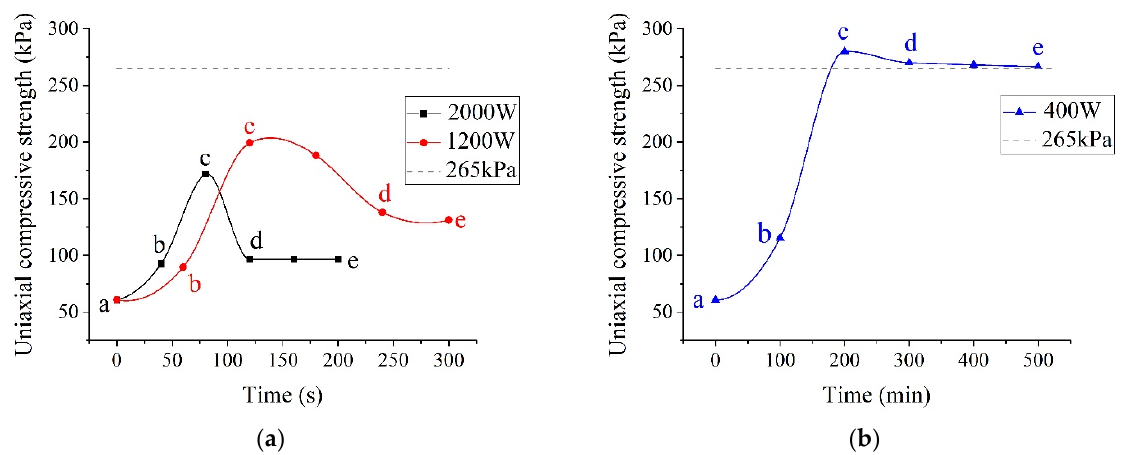
Figure 2. Variation of the uniaxial compressive strength versus time. ( a ) Is the change of material strength with curing time under 1200 W and 2000 W curing conditions, ( b ) Is the change of material strength with curing time under 400 W curing conditions.